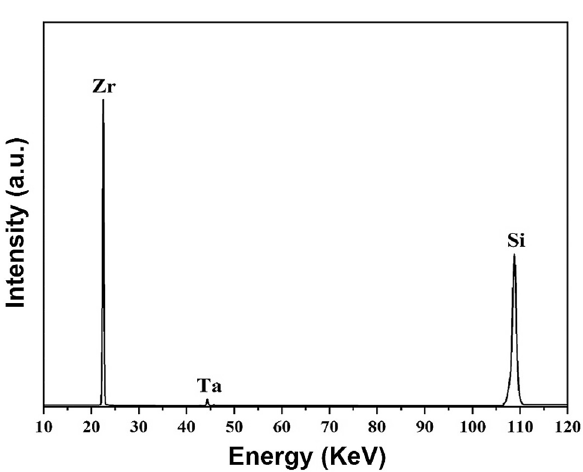
Figure 3. XRF analysis of ZrB 2 -SiC-TaN